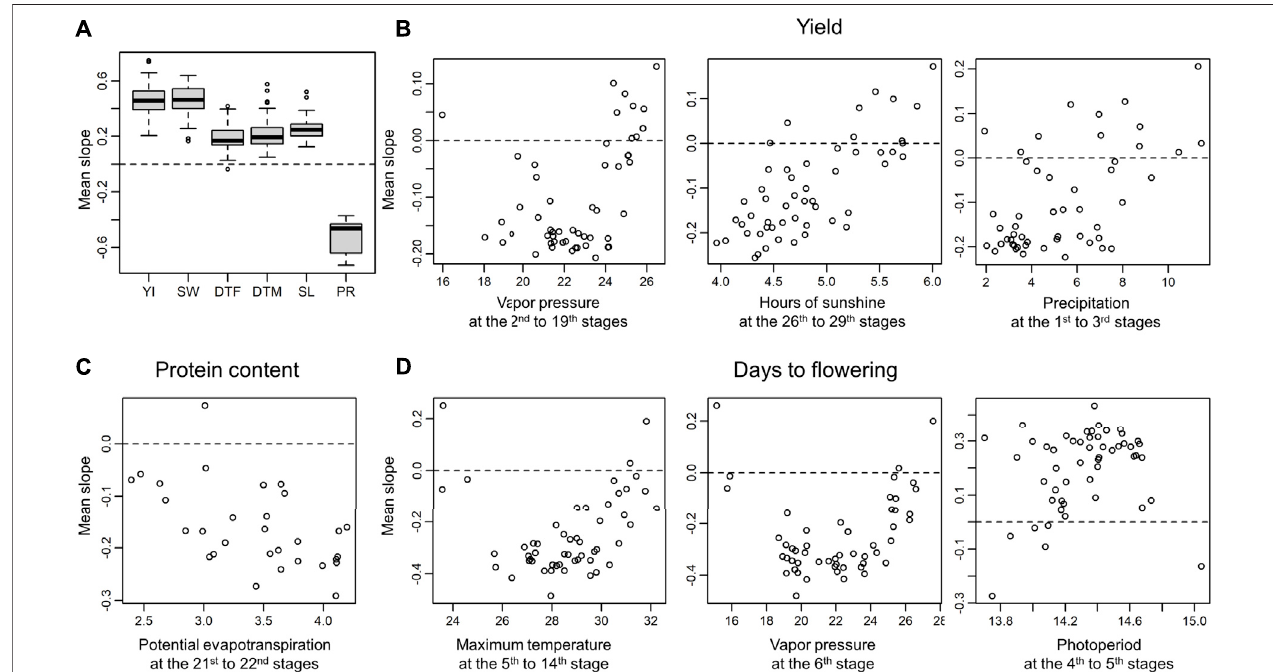
FIGURE 7 | Correlations between environmental covariates and the averages of the slopes of the varieties evaluated at each environment. Positive/negative correlations indicate directional selection for the environmental covariates. (A) Weighted averages of slopes for each trait. YI, yield; SW, seed weight; DTF, days to fl owering; DTM, days to maturity; SL, stem length; PR, protein content. (B) Examples of correlations between the environmental covariates and the averages of the slopesobservedforyield.TheenvironmentcovariatesthatshowedstrongassociationswiththeG × Einteractionsareshown.Theredlinesarethelinearregression lines. (C) Example of correlations between the environmental covariates and the averages of the slopes observed for protein content. The environment covariates that showedthehighestcorrelation withtheG × Einteractionsareshown. (D) Examplesofcorrelationsbetweentheenvironmentalcovariatesandtheaveragesoftheslopes observed for days to fl owering. The two environment covariates that exhibited the highest associations with the G × E interactions and photoperiod at the 4th to 5th stages are shown. The red lines were drawn using the local polynomial regression provided by the R package KernSmooth (ver. 2.23-17) (Wand and Jones,